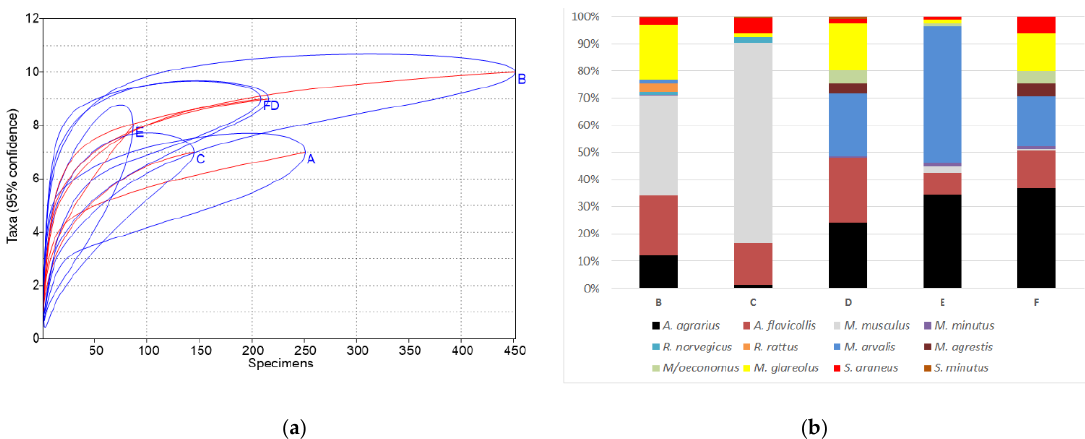
Figure 4. Small mammal species accumulation curves with confidence intervals ( a ) and species share